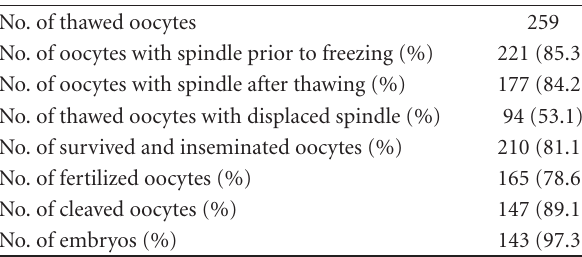
Table 2: Overall results of spindle dynamic